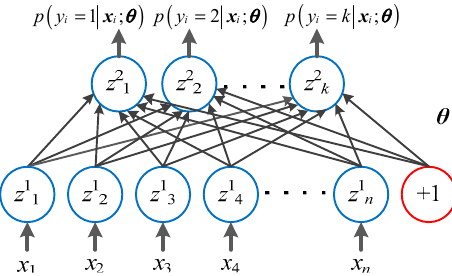
Figure 3. Topology of a simple softmax classifier.